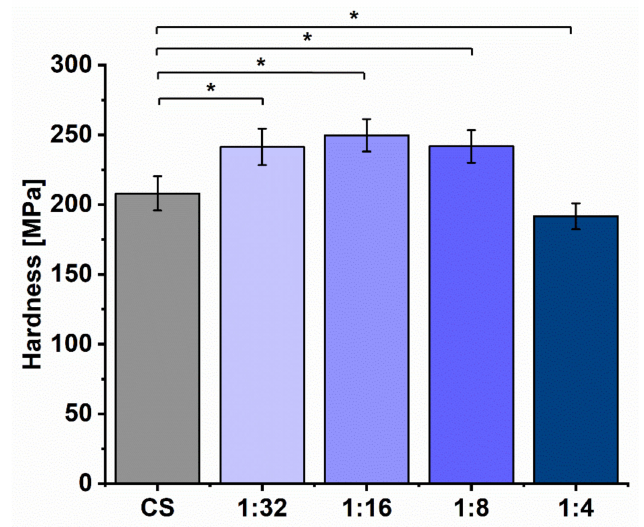
Figure 5. Comparison of the hardness of CS and Ga (III)-CS complex coatings with di ff erent Ga (III) concentrations. Asterisks (*) denote significant di ff erences ( p <